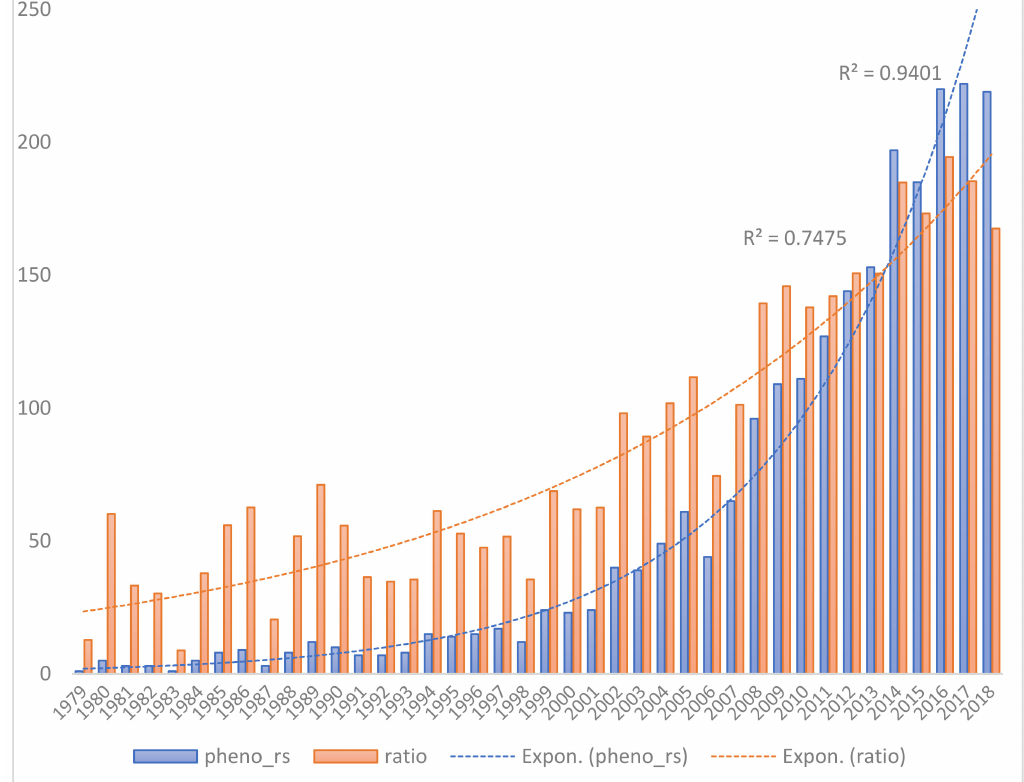
Figure 1. Temporal trend of rs + pheno (remotely sensed phenology) papers over the period 1979–2018. In blue, the total number of rs + pheno papers; in orange, the ratio between the total number of rs + pheno papers and the total number of all the scientific papers multiplied by